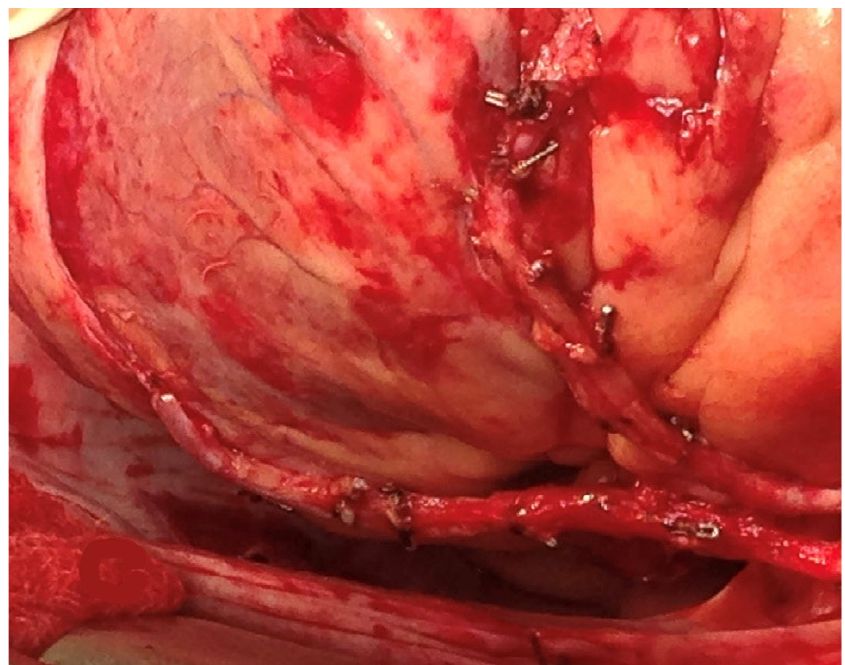
Figure 2. Left internal thoracic artery sequential grafting to the left anterior descending and diagonal arteries and right internal thoracic artery to the obtuse marginal artery. Reproduced from: “Hemo ‐ dynamic changes during heart displacement in aorta no ‐ touch off ‐ pump coronary artery bypass surgery: a pilot study” by Carvalho et al.; Brazilian Journal of Cardio ‐ Vascular Surgery, 2018; Li ‐ cense: CC BY 4.0, https://creativecommons.org/licenses/by/4.0/, accessed on 20 February 2023).